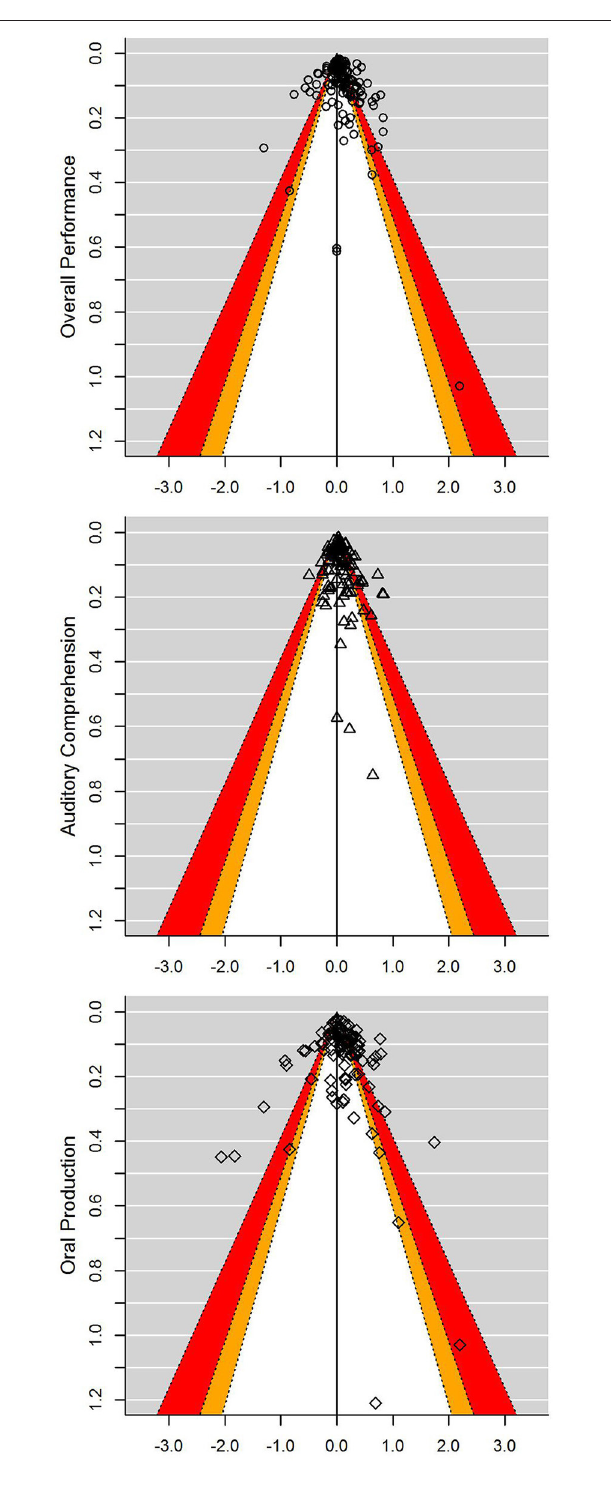
FIGURE 2 | Contour enhanced funnel plots for each of the three types of scores analyzed. Contours change shades at p -levels 0.1 (white), 0.05 (orange), and 0.01 (red). Logarithms of risk ratios are plotted against the SEs , and the reference line indicating the random-effects model estimates for each the three types of scores analyzed. Positive and negative abscissas represent better performance in L1 and L2,